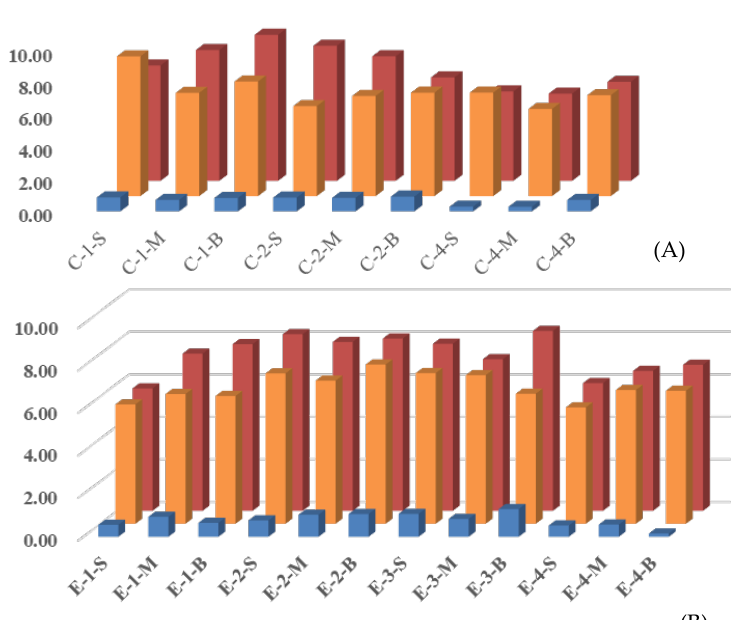
Figure 6. Changes in Bacteroides in the reservoir during the operation of the water-lifting aeration system: ( A ) change in the control area; ( B ) change in the enhanced area. Labeling is consistent with that of Figure 4.